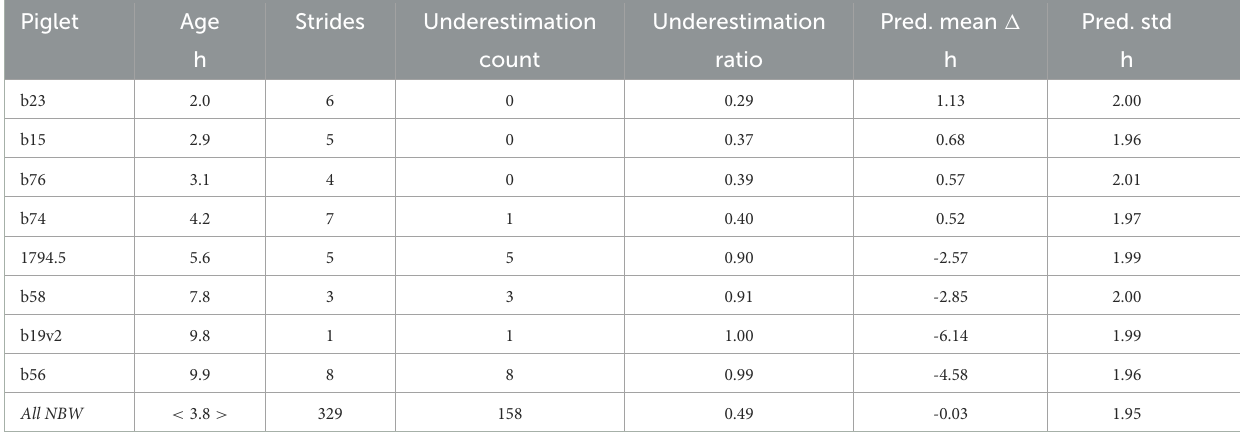
TABLE 1 Age inference per LBW animal (compared to NBW average, last row). Piglet Age Strides Underestimation Underestimation Pred. mean 1 Pred.